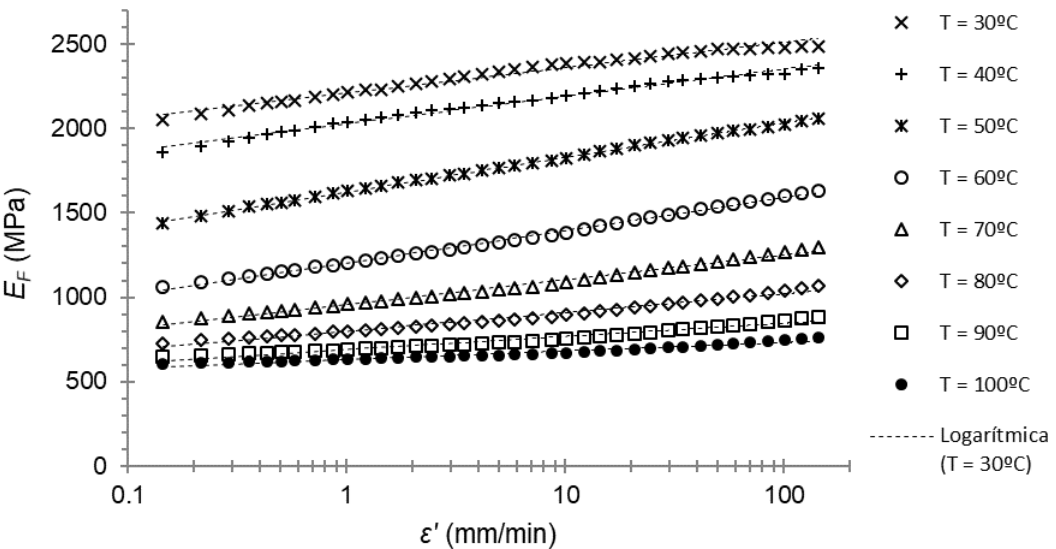
Figure 7. Flexural modulus–strain rate plot of the frequency sweep for PA66. Dotted lines are the mean-square-error fitting lines.